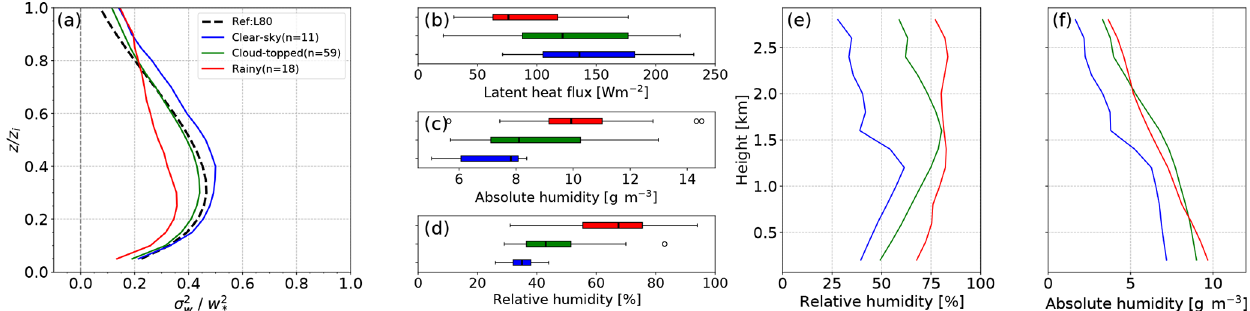
Figure 8. (a) Average profiles of σ 2 w /w 2 ∗ of the three main categories: clear-sky, cloud-topped and rainy days. The universal profile is given as a dashed black line. Box plot of the (b) surface latent heat flux (LHF), (c) absolute humidity and (d) relative humidity (RH) averaged over the three categories and (e) vertical profile of relative humidity and (f) absolute humidity at 12:00UTC in the boundary layer averaged over the three main categories from radiosonde data (https://weather.uwyo.edu/upperair/sounding.html, last access: 5 January